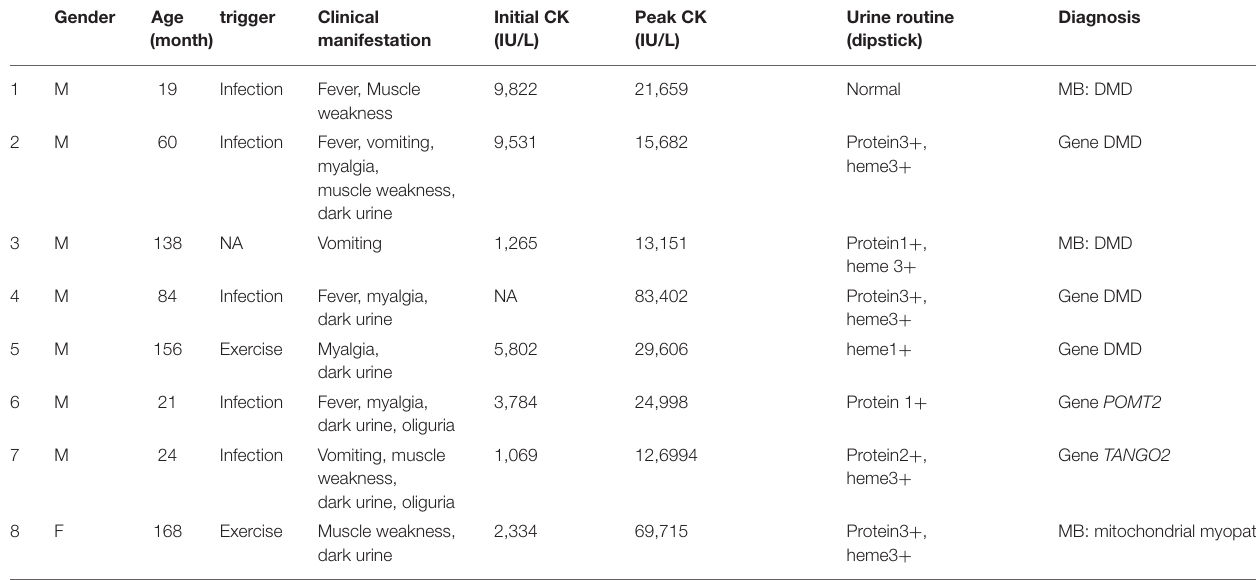
TABLE 3 | Data for RM patients with hereditary myopathy. Gender